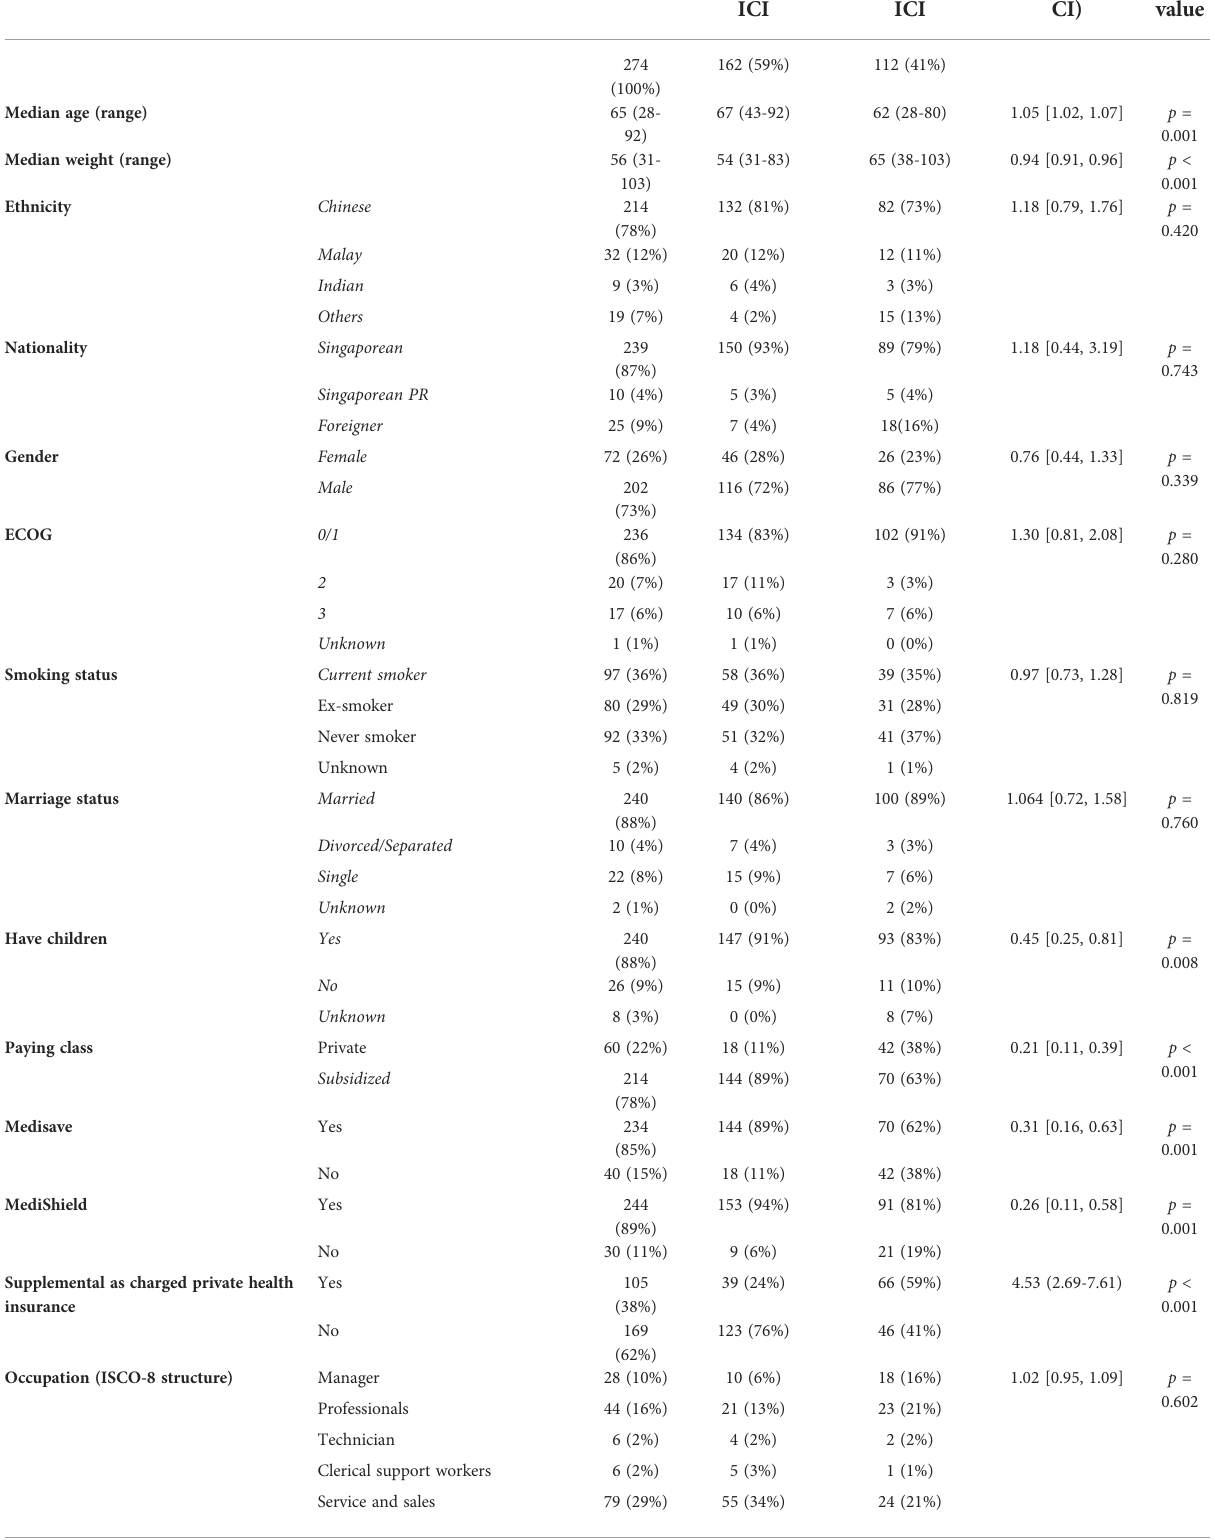
TABLE 1 Patient